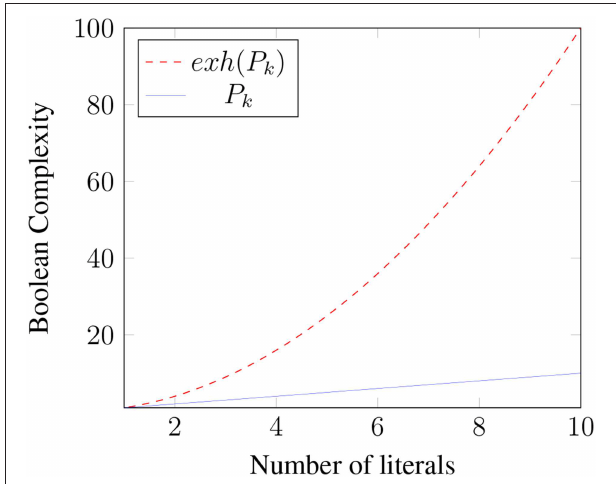
FIGURE 1 | Growth of Boolean